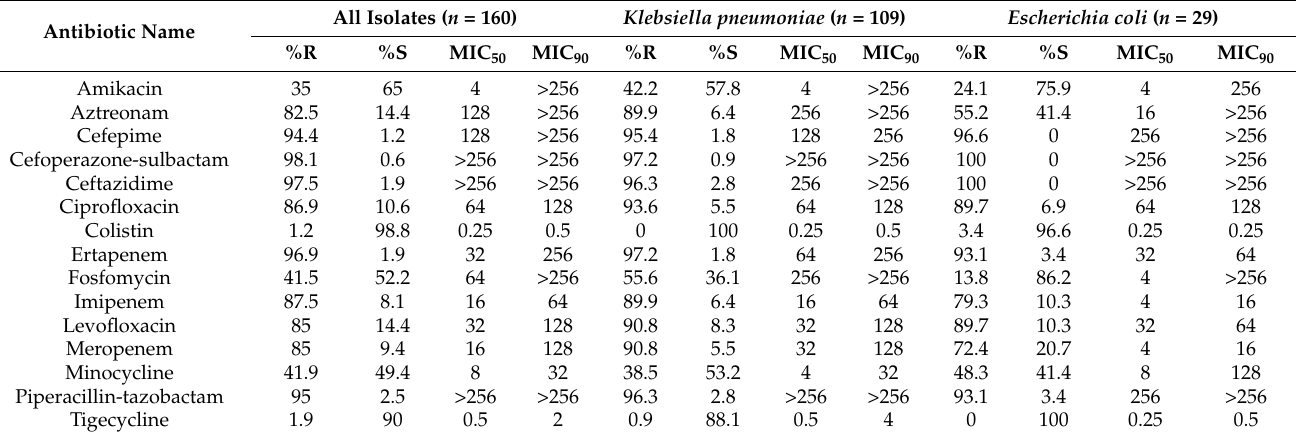
Table 1. Antimicrobial Susceptibility Testing Results of CRE Isolates.